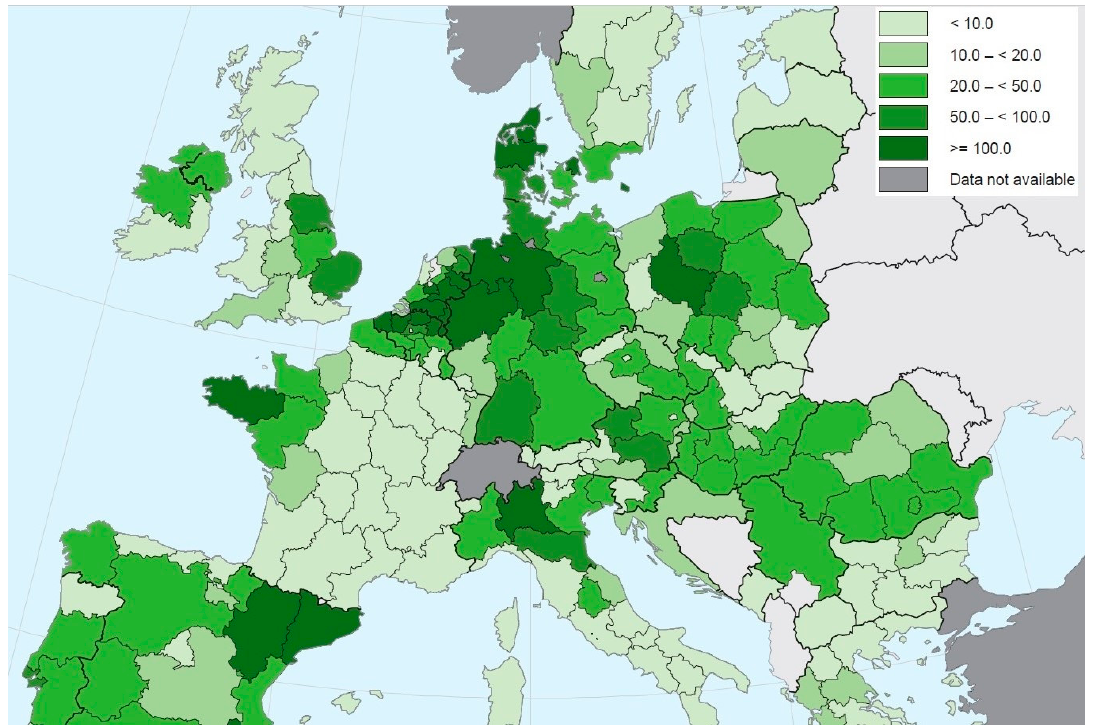
Figure 2. Domestic pig population (average number per km 2 ) in Europe. Adapted from [37].